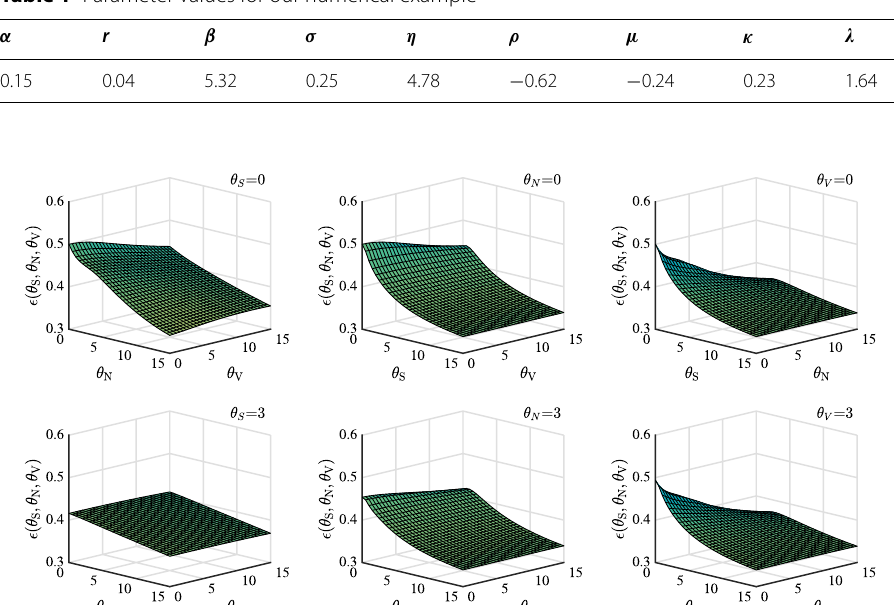
Fig. 1 DEP in stock market as a function of ambiguity parameters θ S , θ V and θ N . Panel ( a ), ( b ), and ( c ) set θ S , θ N , and θ V as 0, respectively. By contrast, Panel ( d ), ( e ), and ( f ) set θ S , θ N , and θ V as 3,